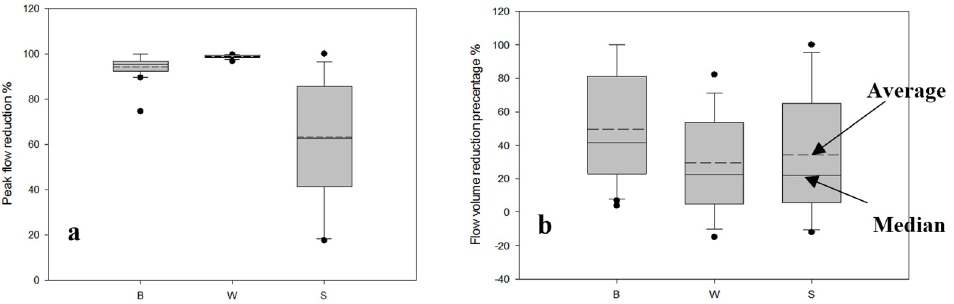
Figure 2. Hydraulic performance of WSUDs, ( a ) peak flow reduction; ( b ) flow volume reduction. B = bioretention basin; W = constructed wetland; S = roadside swale.